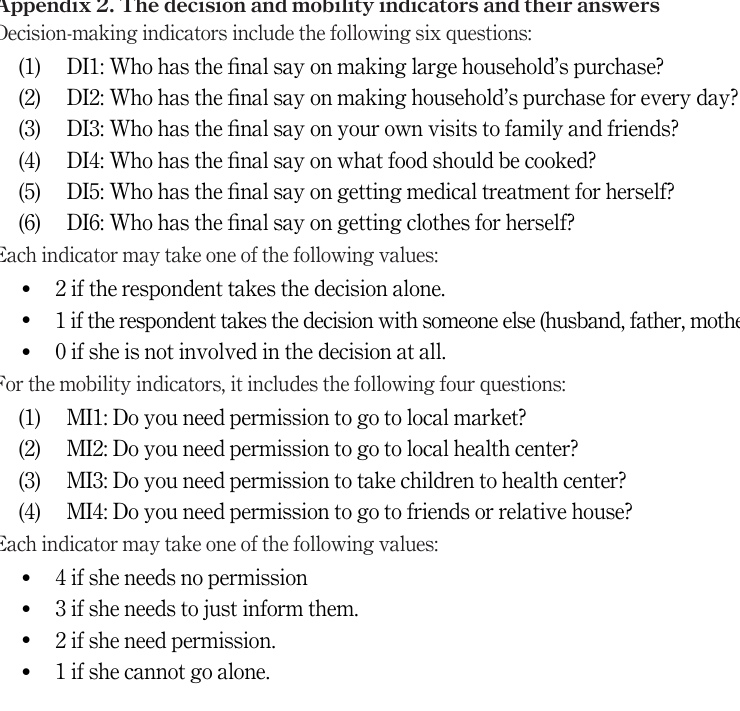
Figure A1. MIMIC